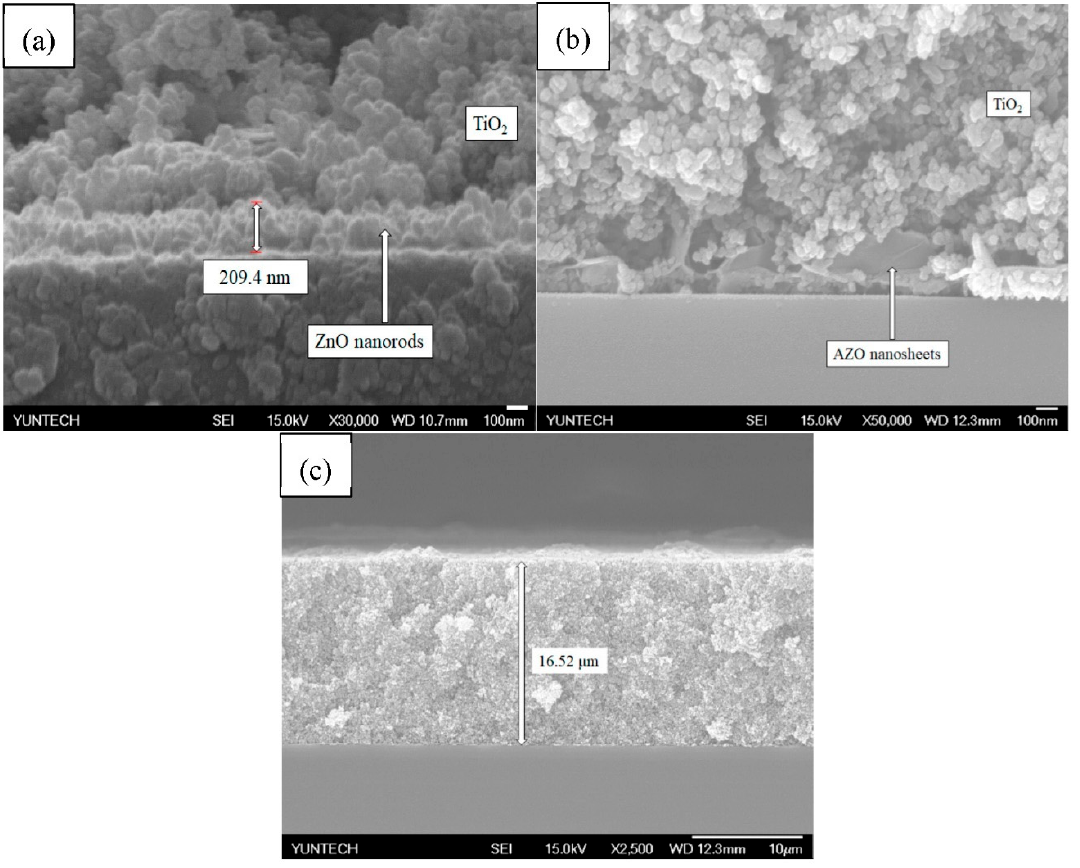
Figure 6. FE-SEM cross-view images of ( a ) ZnO nanorods / titanium dioxide (TiO 2 ), ( b ) AZO nanosheets / TiO 2 , and ( c ) TiO 2 .